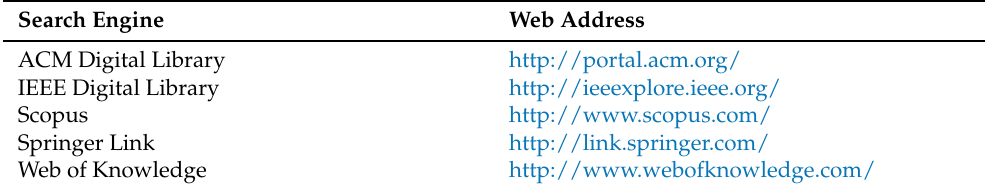
Table 2. List of selected sources and their Internet addresses—accessed in January 2022. Search